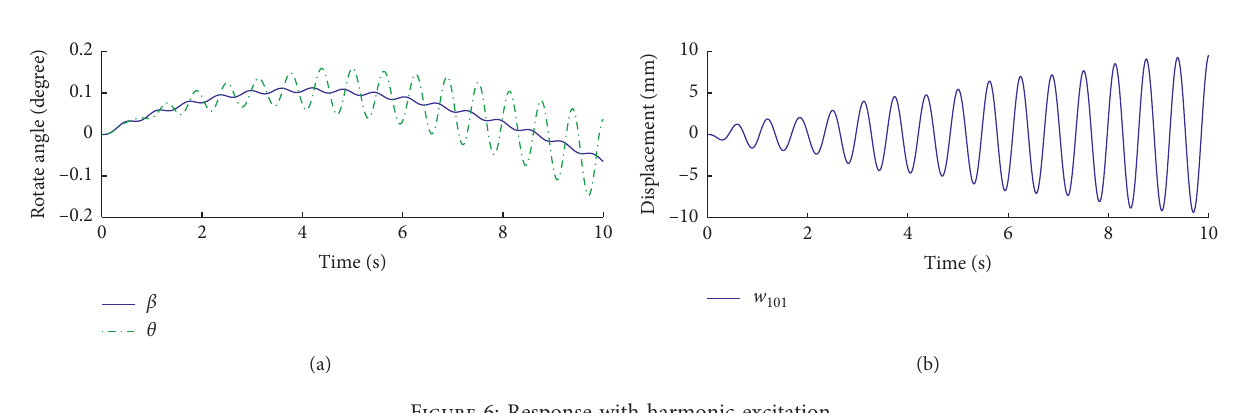
Figure 5: Response with step excitation.